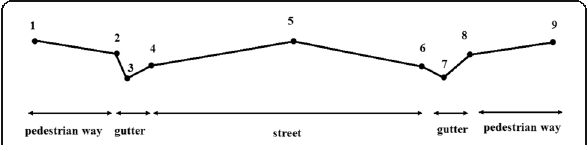
Fig. 3 A typical profile of cross sections